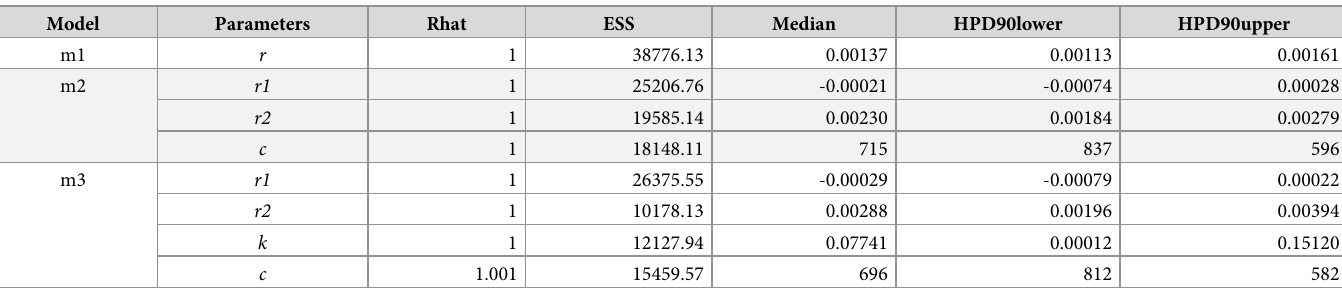
Table 2. Fitted parameter summaries.